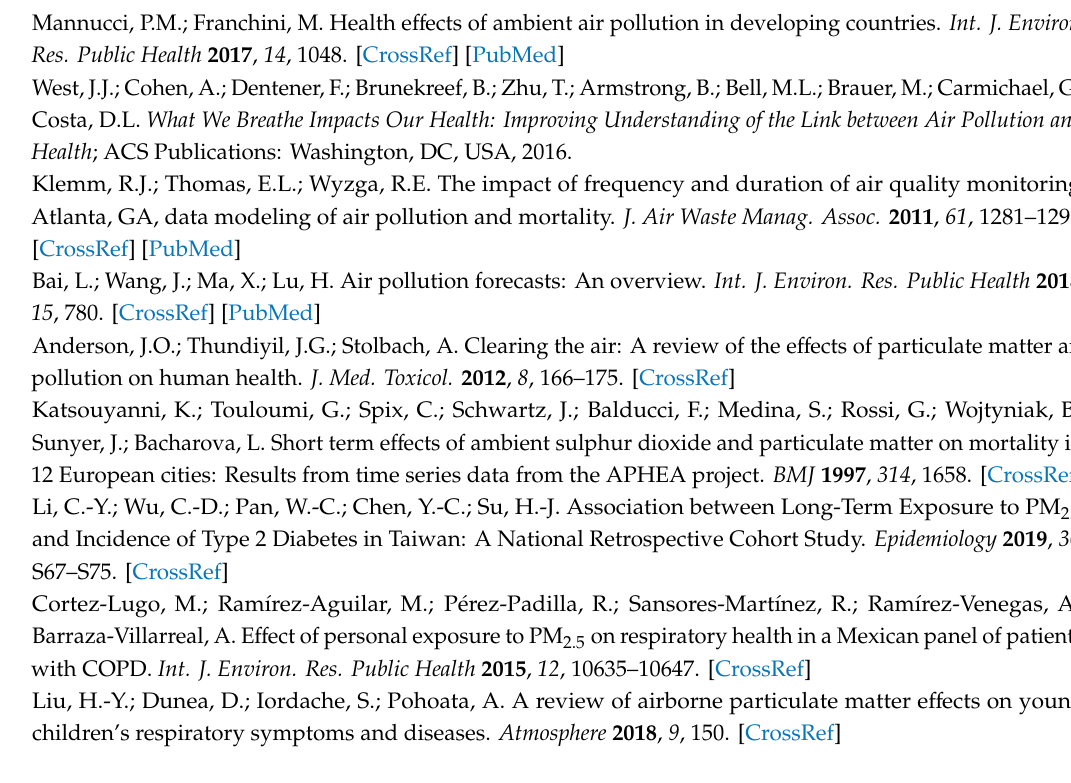
Figure A1. ( a ) k ( x ) , ( b ) a ( x ) , ( c ) b ( x ) coe ffi cient Figure A1. ( a ) ｋ (𝑥), ( b ) a(x) , ( c ) b(x) coefficient maps.